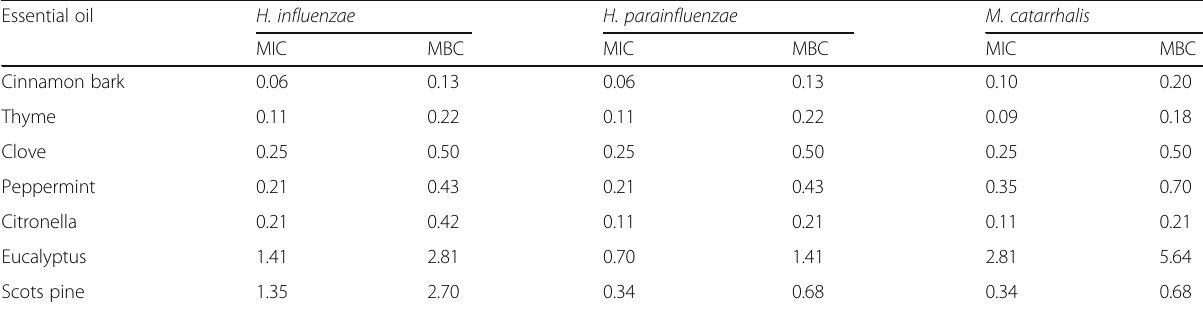
Table 3 Antibacterial activity of EOs against Haemophilus spp. and M. catarrhalis by broth macrodilution Essential